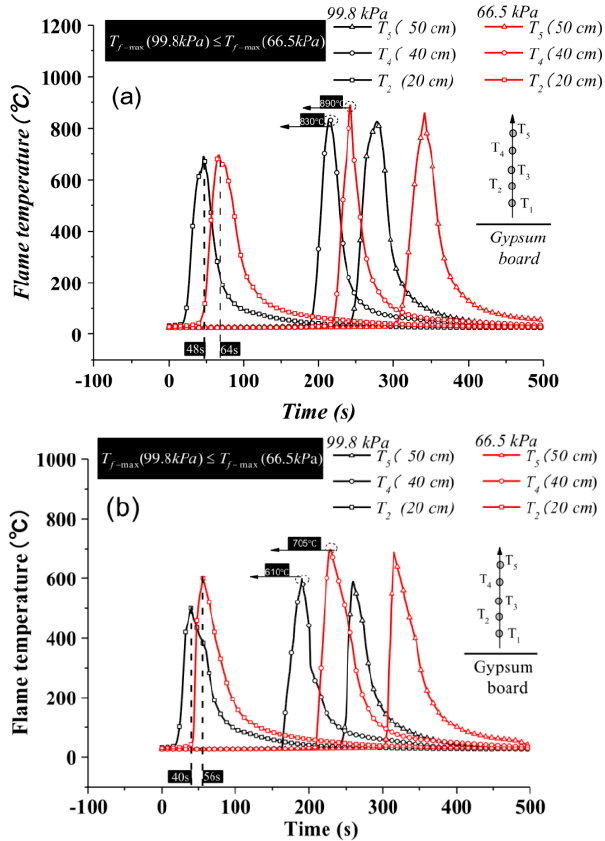
Figure 19. Axial temperature in the plume region at tilt angles of ( a ) 30° and ( b ) 60° [29]. Figure 15. Axial temperature in the plume region at tilt angles of ( a ) 30 ◦ and ( b ) 60 ◦